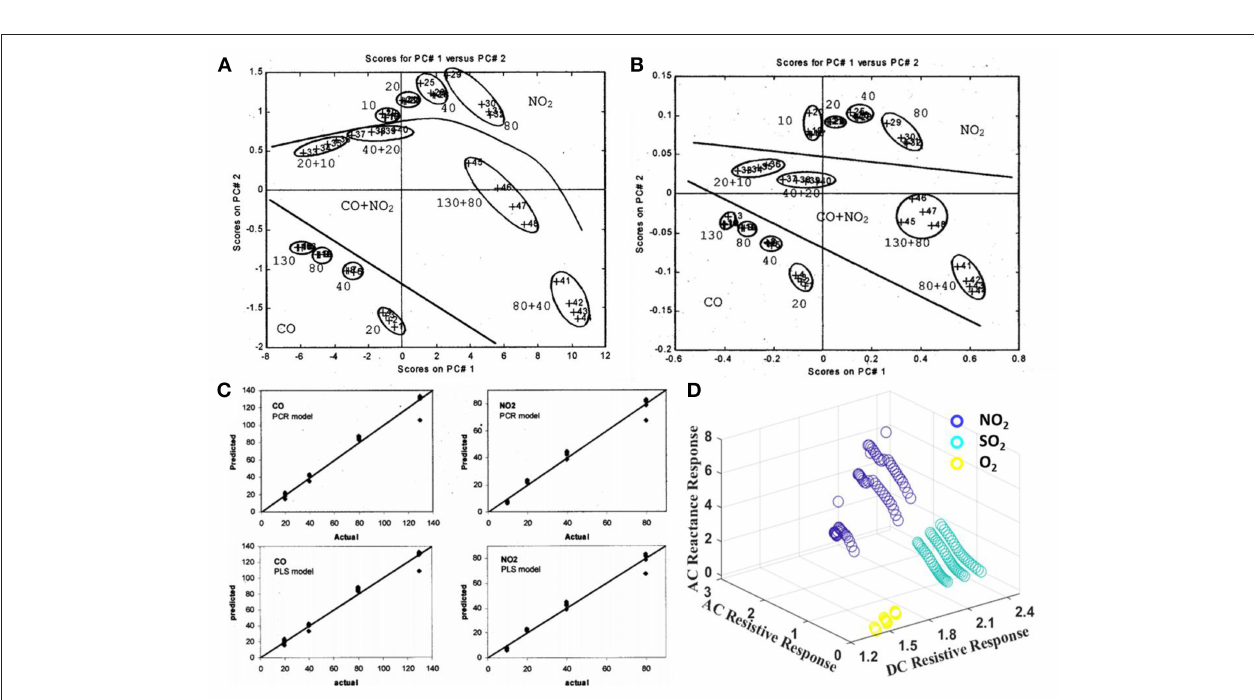
FIGURE 13 | (A) Fabrication schematic of Heterogeneous Nanomaterial Array synthesized by Series of Localized Liquid-Phase method. Estimation of concentrations of NO 2 and CO gases in sample gas I (B) and II (C) . Reprinted with permission from Yang et al. (2015), copyright 2015 American Chemical Society.